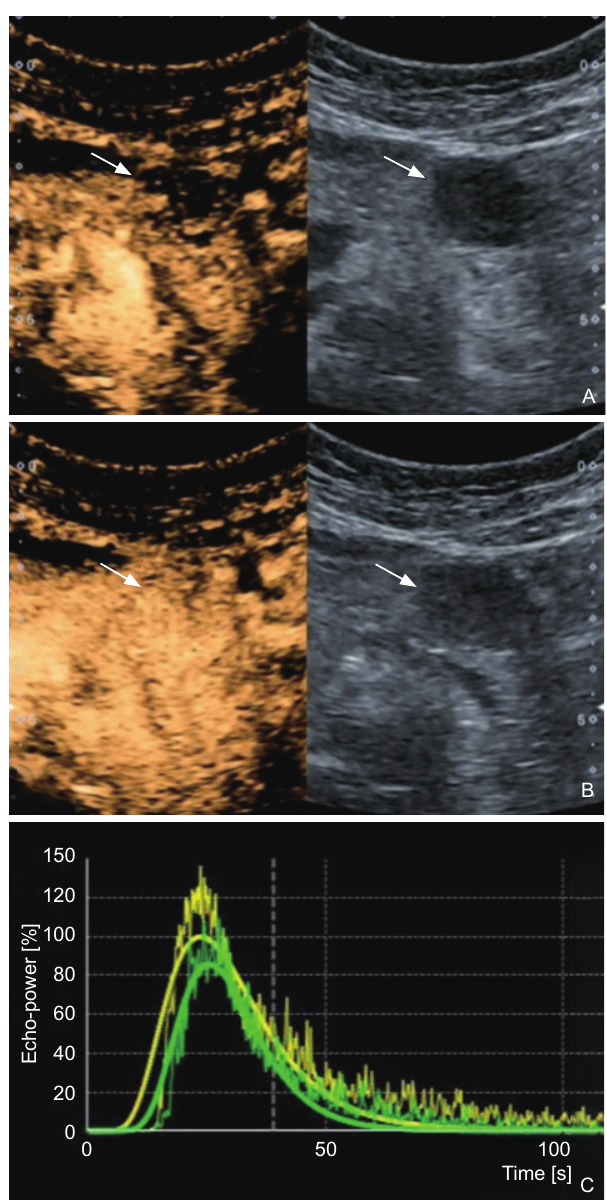
Figure 2 (A) At 17 s, the contrast-enhanced ultrasonography of the lesion (arrows) exhibited peripheral enhancement heterogeneously; (B) The enhancement intensity of the lesion (arrows) peaked at 26 s; (C) The time- intensity curves were presented (green curve, tumor; yellow curve, normal pancreatic